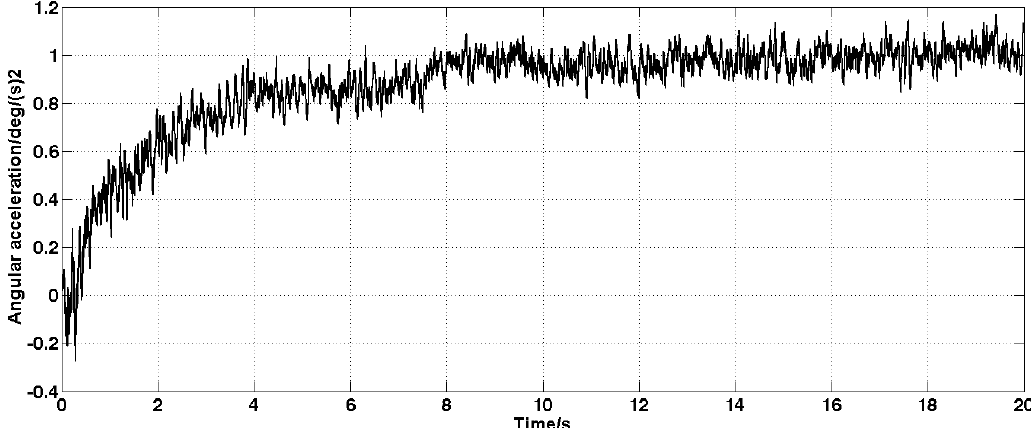
Sensors 2019 , 19 , x FOR PEER REVIEW Figure 8. Estimation of accelerometer drift. Figure 8. Estimation of accelerometer drift.